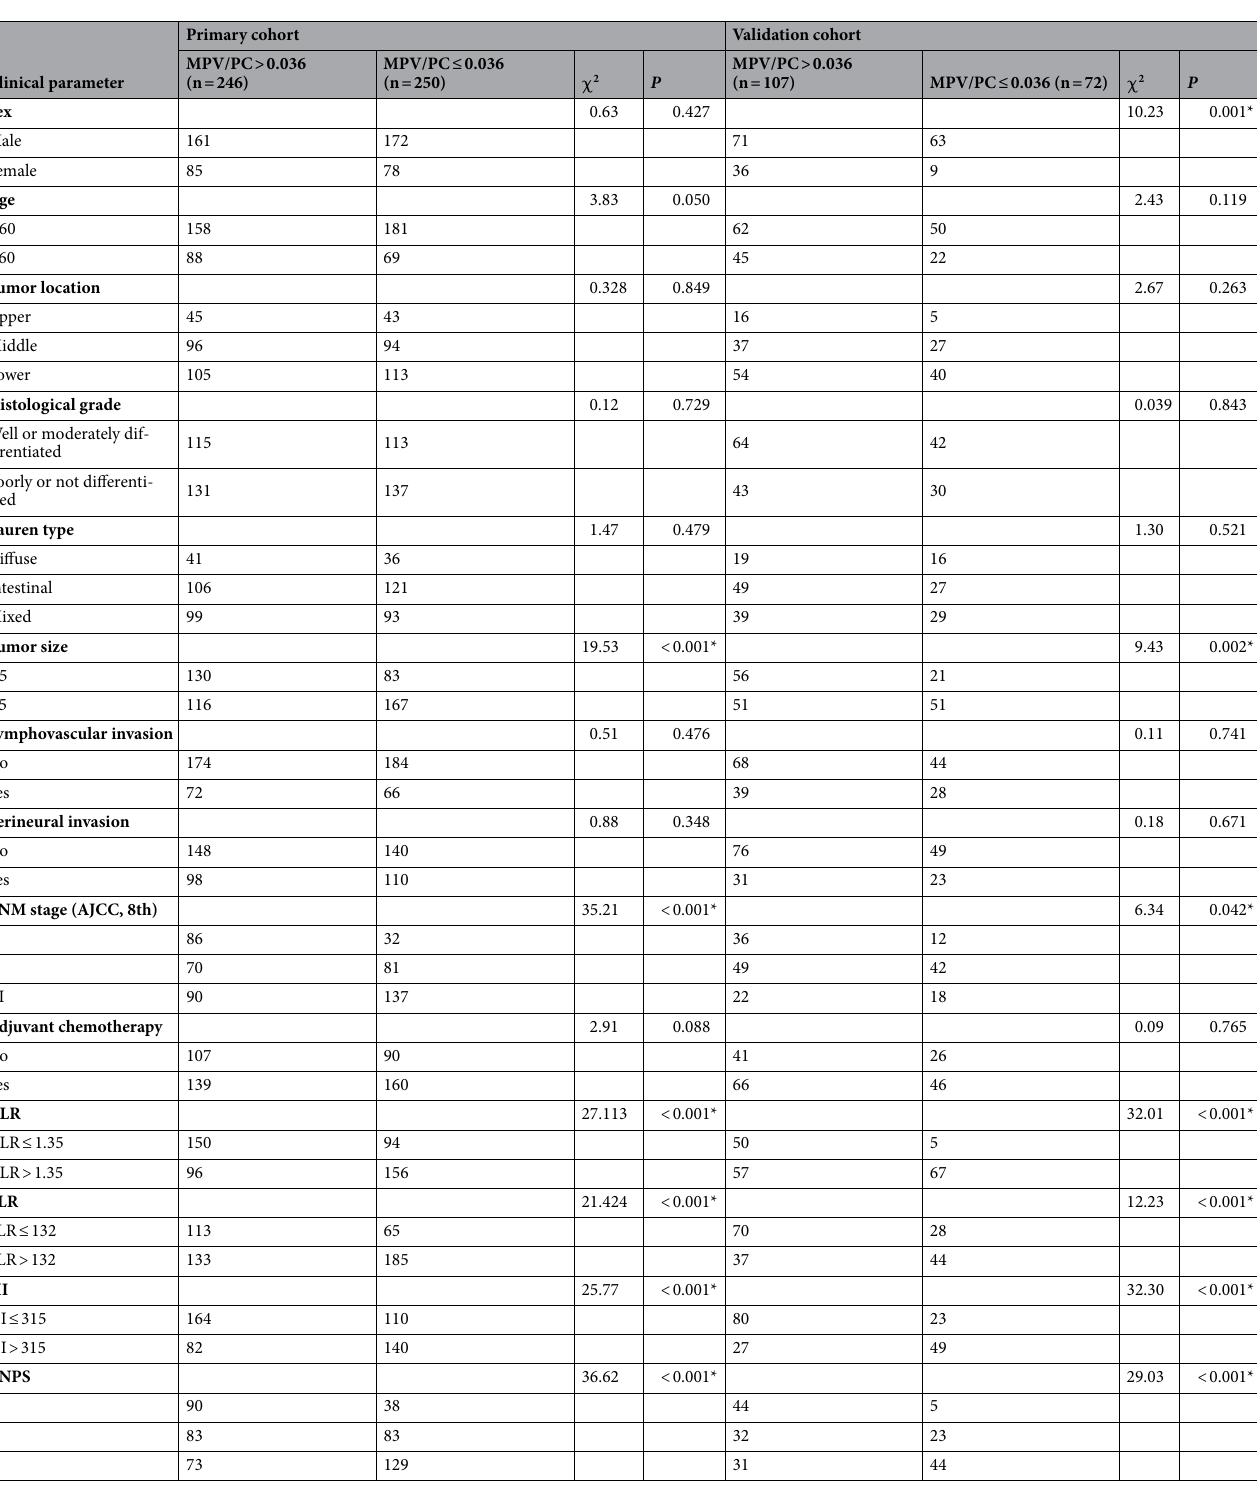
Table 1. Baseline characteristics for patients with MPV/PC > 0.036 versus MPV/PC ≤ 0.036 in primary and validation cohort. TNM tumor, node, metastasis, AJCC American Joint Committee on Cancer, MPV/PC mean platelet volume to platelet count, NLR neutrophil-to-lymphocyte ratio, PLR platelet-to-lymphocyte ratio, CNPS combined neutrophil-platelet score, SII systemic immune-inflammation index. *Represents a statistically